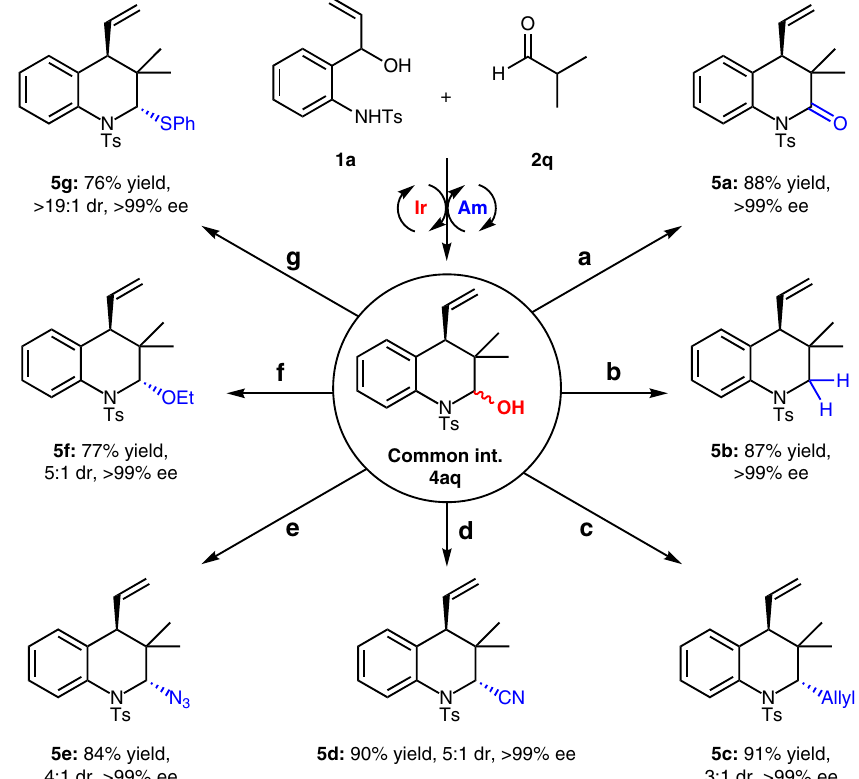
Fig. 4 Divergent synthetic transformations of chiral hemiaminal 4aq . Reaction conditions: a ) PCC (5.0 eq.), silica (100 mg), CH 2 Cl 2 (5 mL), 40 °C, 10 h; b ) Et 3 SiH (3.0 eq.), Et 2 O · BF 3 (3.0 eq.), CH 2 Cl 2 (3 mL), 0 °C, 5 min; c ) allyltrimethylsilane (3.0 eq.), Et 2 O · BF 3 (3.0 eq.), CH 2 Cl 2 (3 mL), 0 °C, 5 min; d ) TMSCN (2.0 eq.), Et 2 O · BF 3 (3.0 eq.), CH 2 Cl 2 (3 mL), 0 °C, 5 min; e ) TMSN 3 (2.0 eq.), Et 2 O · BF 3 (3.0 eq.), CH 2 Cl 2 (3 mL), 0 °C, 5 min; f ) p -TSA (20 mol%), EtOH (2.5 mL), 30 °C, 10 h. g ) PhSH (1.5 eq.), Et 2 O · BF 3 (3.0 eq.), CH 2 Cl 2 (3 mL), 0 °C, 5 min; isolated yield; the ee and dr values